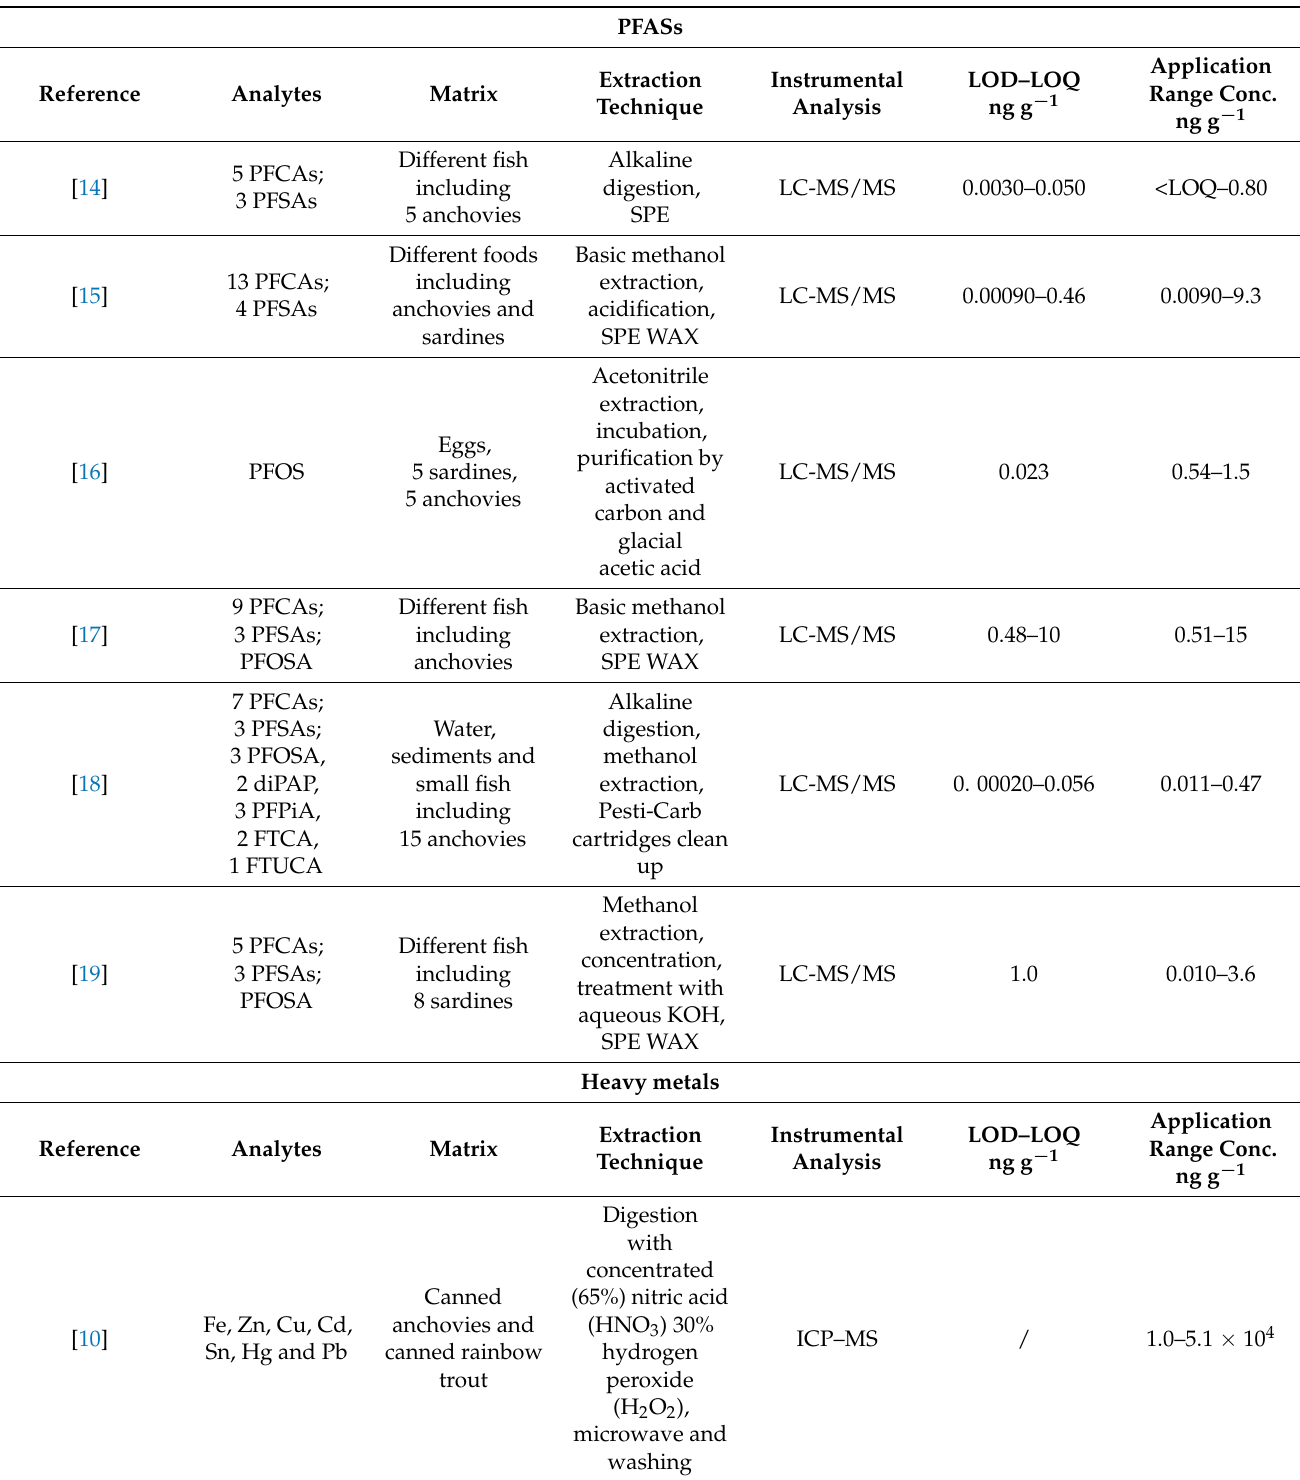
Table 1. State of the art on detection of PFASs and potentially toxic elements in fresh and canned anchovies.